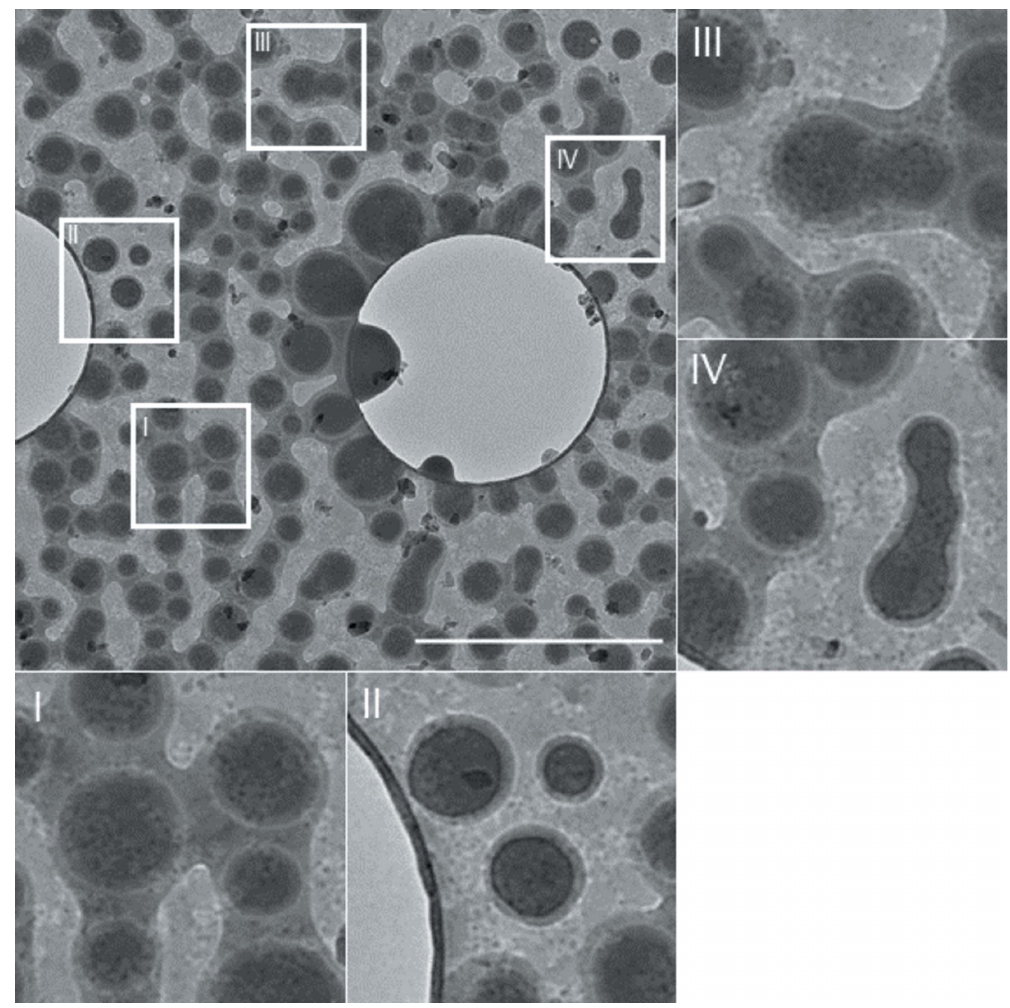
Figure 3 Images taken at 100 K after crystallization for 20 s and vitrification. Scale bar = 2 m m. I shows the droplet-like structures with a surrounding film of mother liquor and II shows the same structures without the surrounding film. III and IV show these structures coalescing inside and outside the